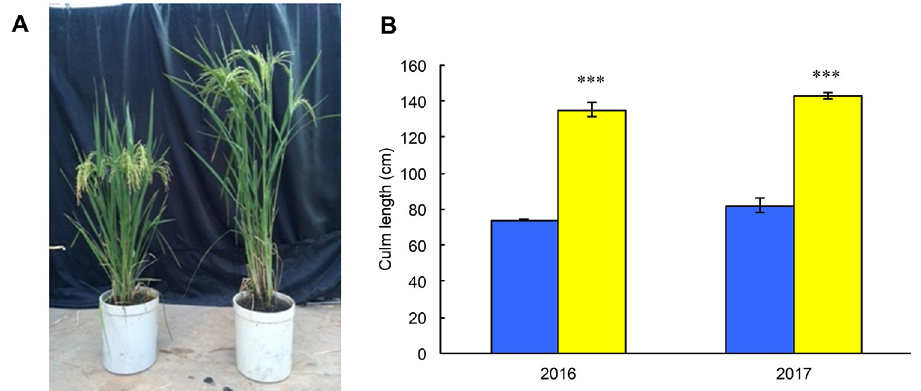
Fig 2. Plant appearance and culm length of Takanari and Monster Rice 1. (A) Plant appearance. Left and right plants indicate Takanari (a semidwarf variety) and Monster Rice 1 (an extra-long-culm line), respectively. (B) Culm length. Blue and yellow bars indicate mean ± SD (n = 3) of Takanari and Monster Rice 1, respectively. Asterisks indicate significant difference between both cultivars: ��� indicates P < 0.001 (t-test).